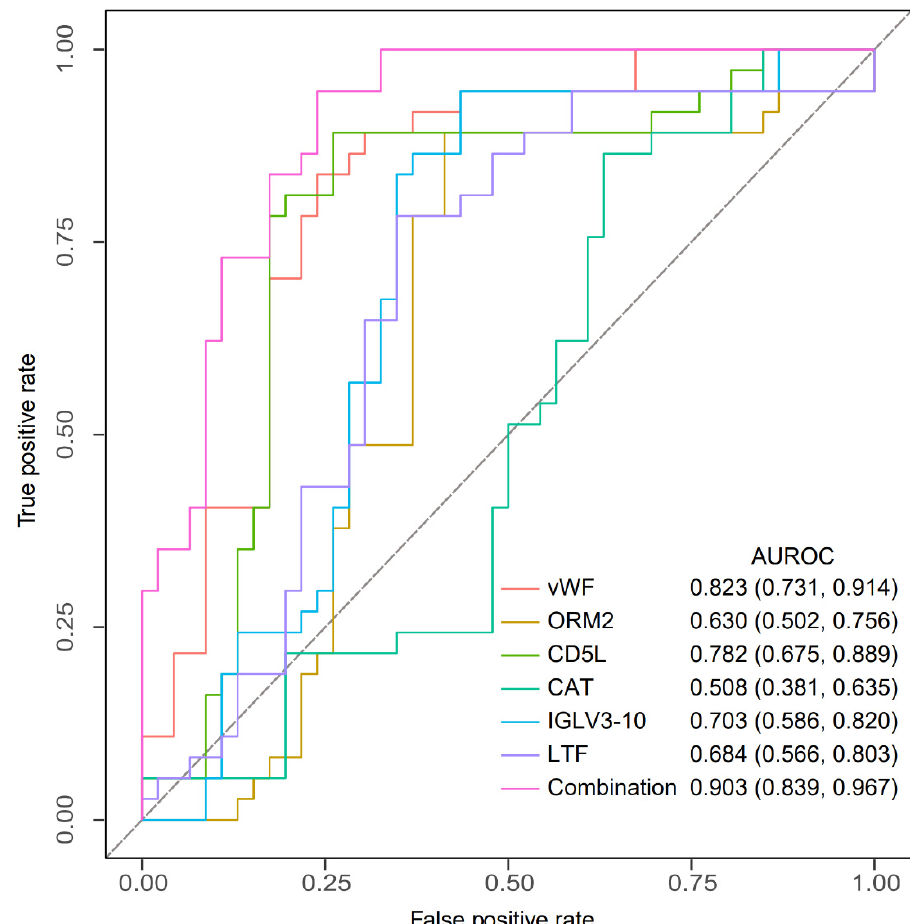
Figure 6. The receiver operating characteristic curves and area under the receiver operating characteristic curves of these candidate biomarkers. VWF, von Willebrand factor; ORM2, alpha-1-acid glycoprotein 2; CD5L, CD5 antigen-like; CAT, catalase; IGLV3-10, immunoglobulin lambda variable 3-